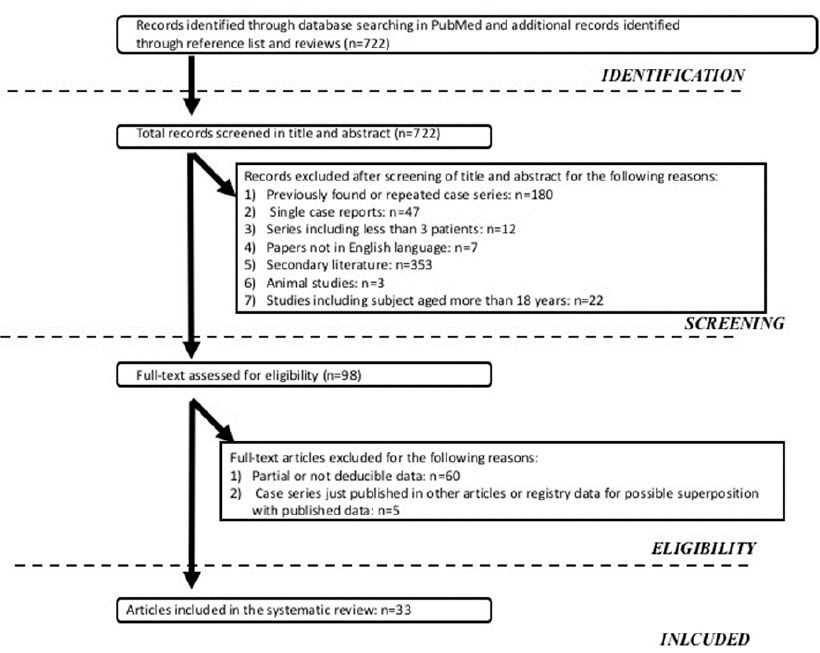
Figure 1. Algorithm of studies selection.